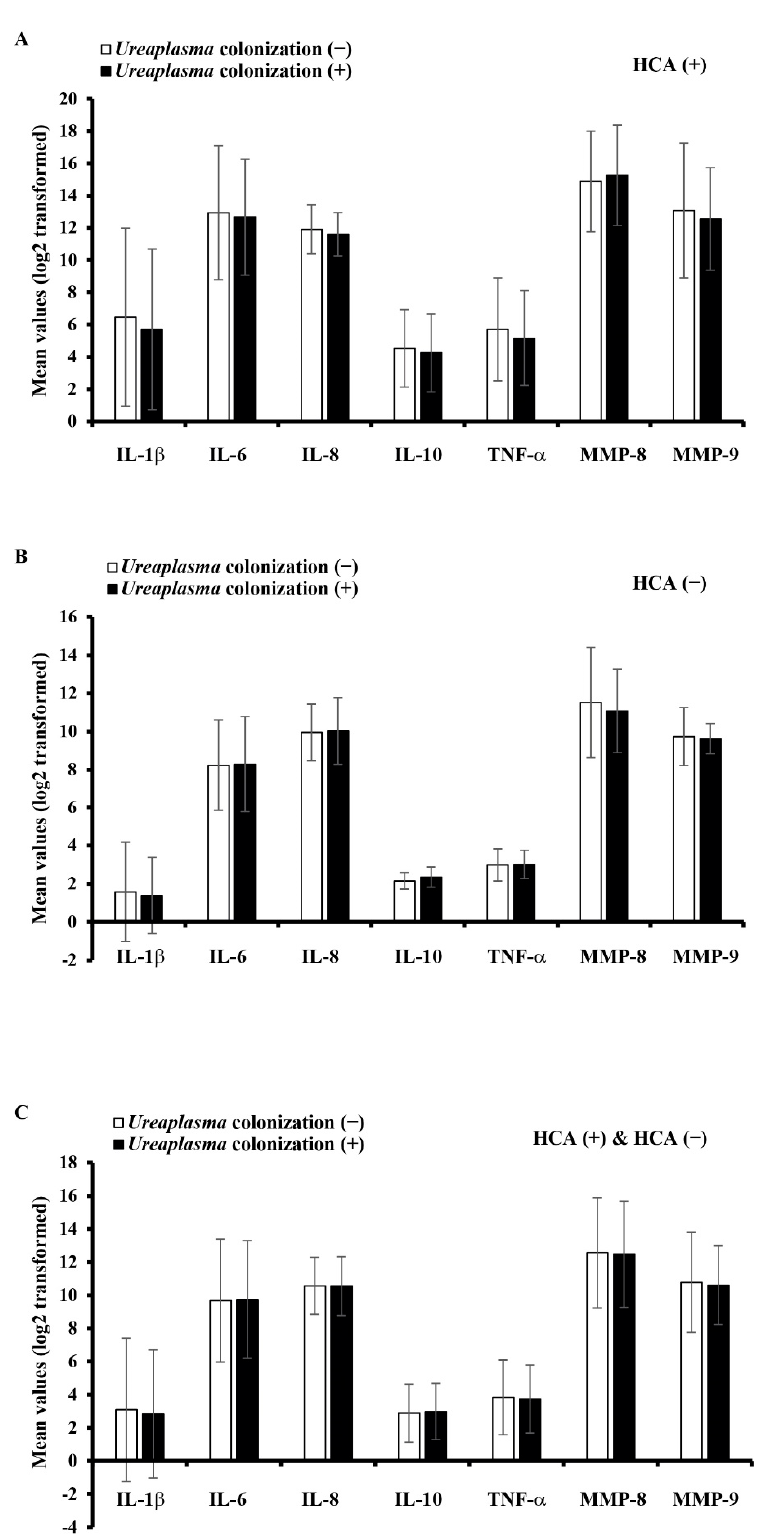
Figure 3. Comparison between the intensity of intraamniotic inflammatory mediators and cervical Ureaplasma spp. colonization according to the presence or absence of histologic chorioamnionitis. ( A ) HCA (+), ( B ) HCA ( − ), and ( C ) HCA (+), HCA ( − ). All data were not significant ( p > 0.05). Histo- logic chorioamnionitis (HCA); Interleukin (IL); Tumor necrosis factor (TNF); Matrix metalloproteins (MMP); Interleukin (IL); Tumor necrosis factor (TNF); Matrix metalloproteins (MMP).